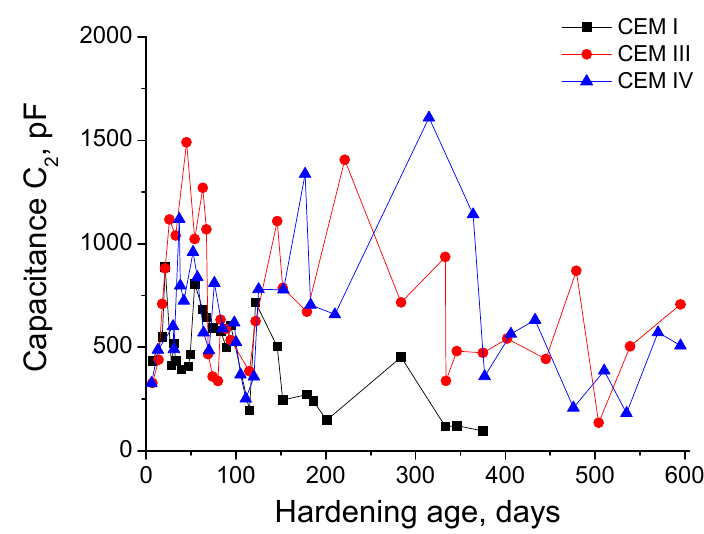
Figure 5. Results of capacitance C 2 for CEM I, CEM III and CEM IV grouts.